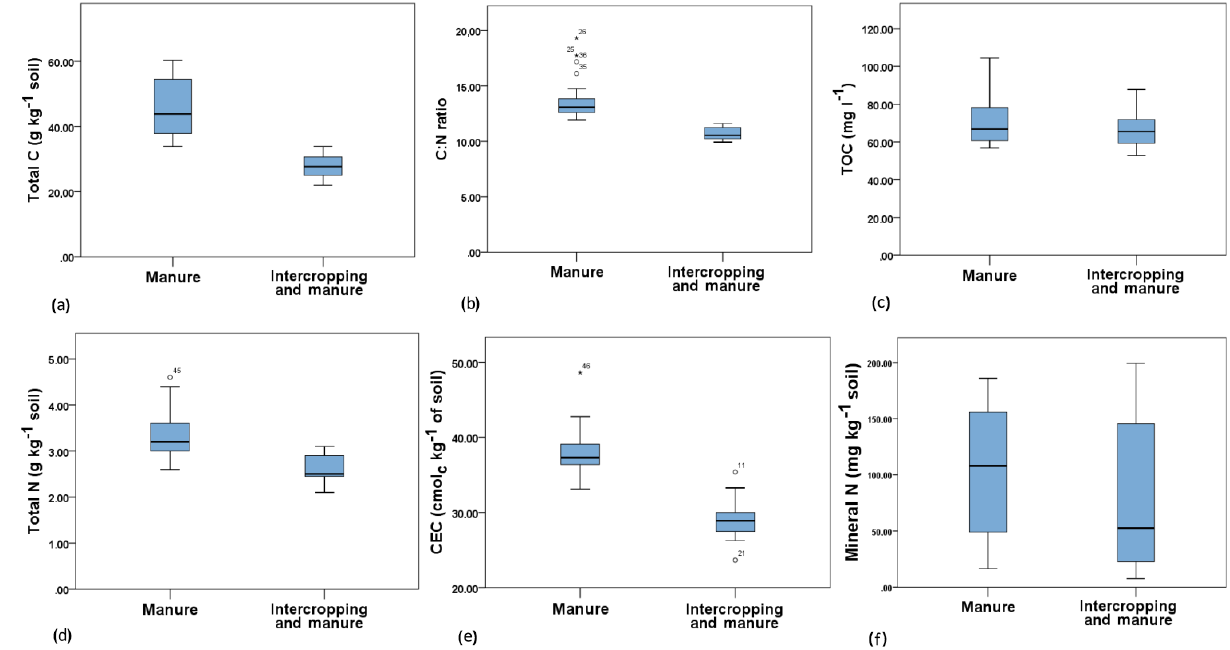
Figure 2. Boxplots showing the differences between (a) total C (gkg − 1 soil), (b) C / N ratio, (c) total organic C in the extracts (mgL − 1 ), (d) total N (gkg − 1 soil), (e) cation exchange capacity (CEC in cmol c kg − 1 ), and (f) mineral N (mgkg − 1 soil) for the agricultural management practices of manure and intercropping and